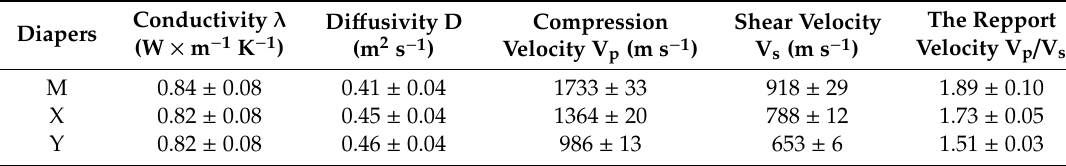
Table 2. Physical properties of layers M, X and Y.